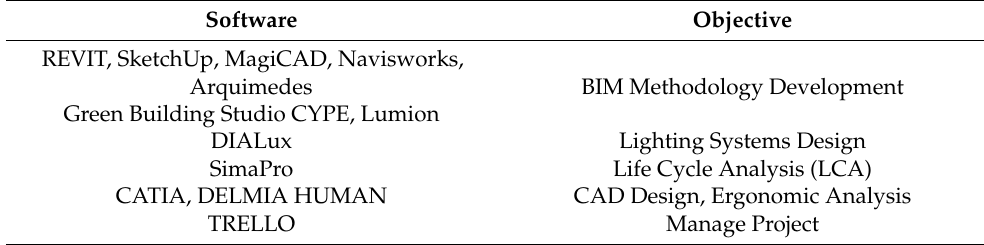
Table 1. Practical sessions in laboratory: Tools and objectives.